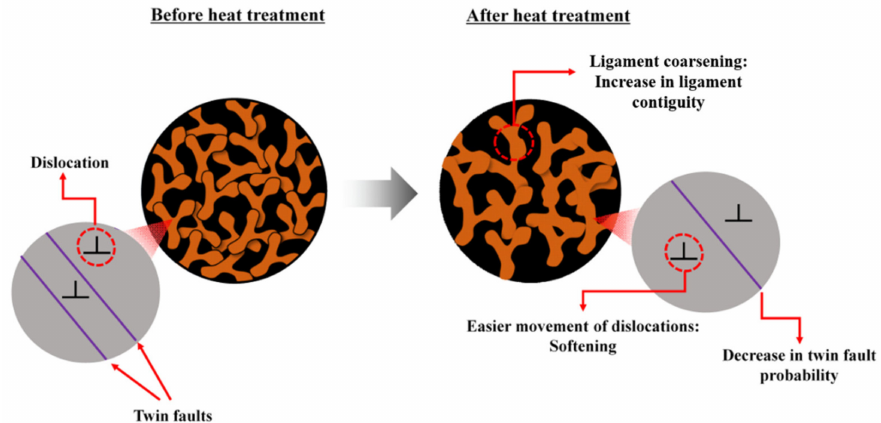
Figure 7. Schematic of the annealing-induced toughening mechanisms observed in this study, including ligament contiguity increase via ligament coarsening and softening via decrease of the twin fault